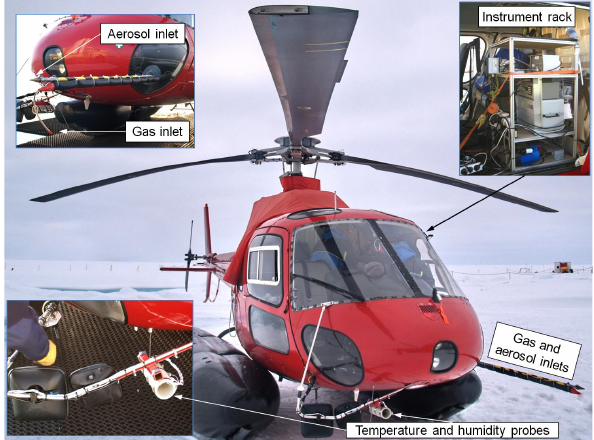
Fig. 10. Photograph of the helicopter that was used for vertical pro- filing, outlining some of the installations to sample meteorology, aerosol particles and trace